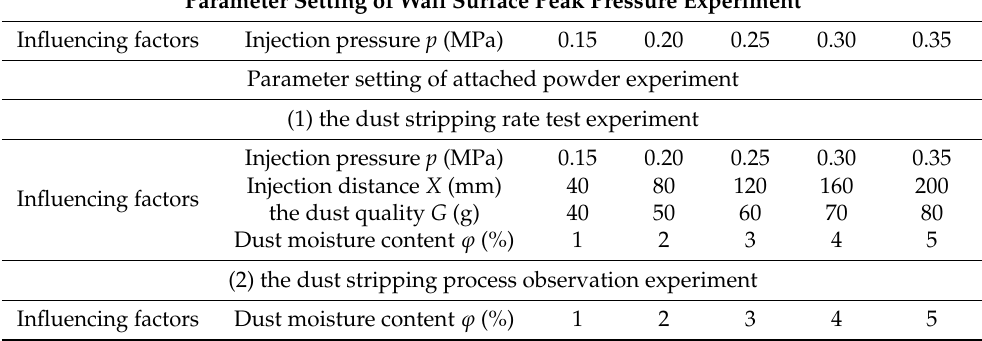
Table 2. The NSMMFP conditions